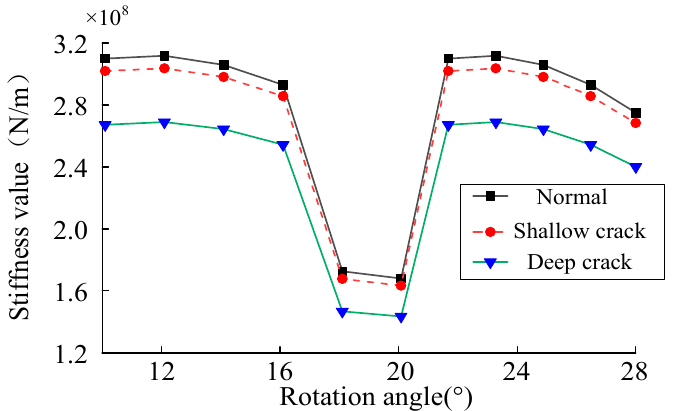
Figure 7. Meshing stiffness under different fault states.